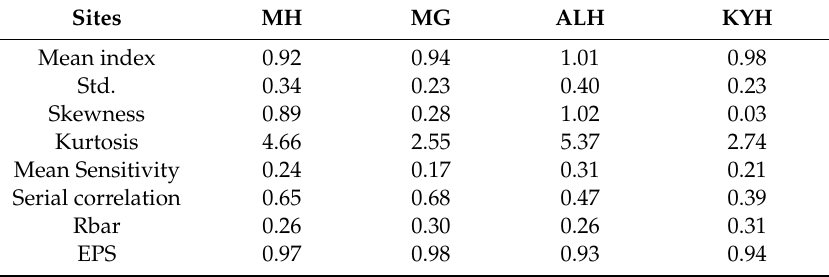
Figure 2. The standard (STD) chronologies and the number of trees for each site. Table 2. General statistics of the standard chronologies for four